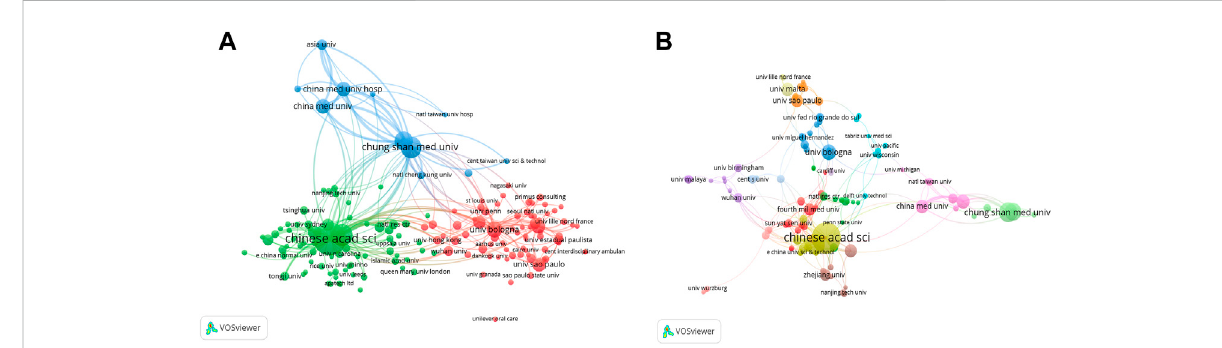
FIGURE 4 The analysis of institutions. (A) Network map of institutions publication about CSB in medicine fi eld by VOSviewer. (B) Co-authorship analysis between institutions with more than three publications. The color indicated clusters, circle size indicated number of publications, the thickness of lines indicated strength of linkage.